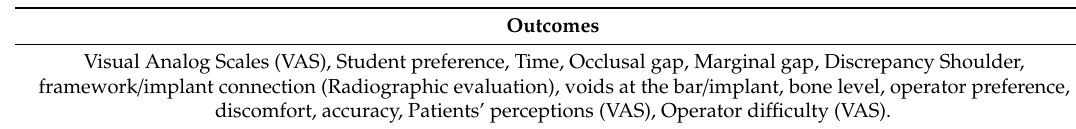
Table 3. Outcomes by the results.